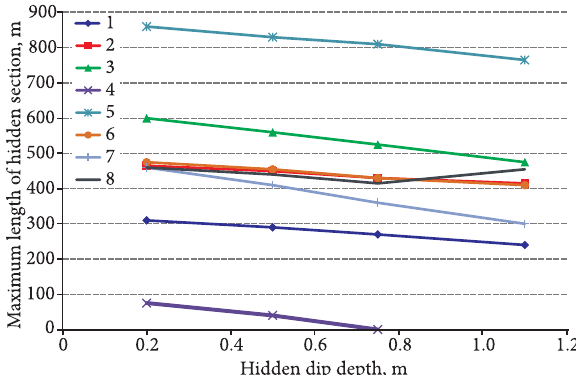
Fig. 5. Max length of hidden section versus hidden dip depth